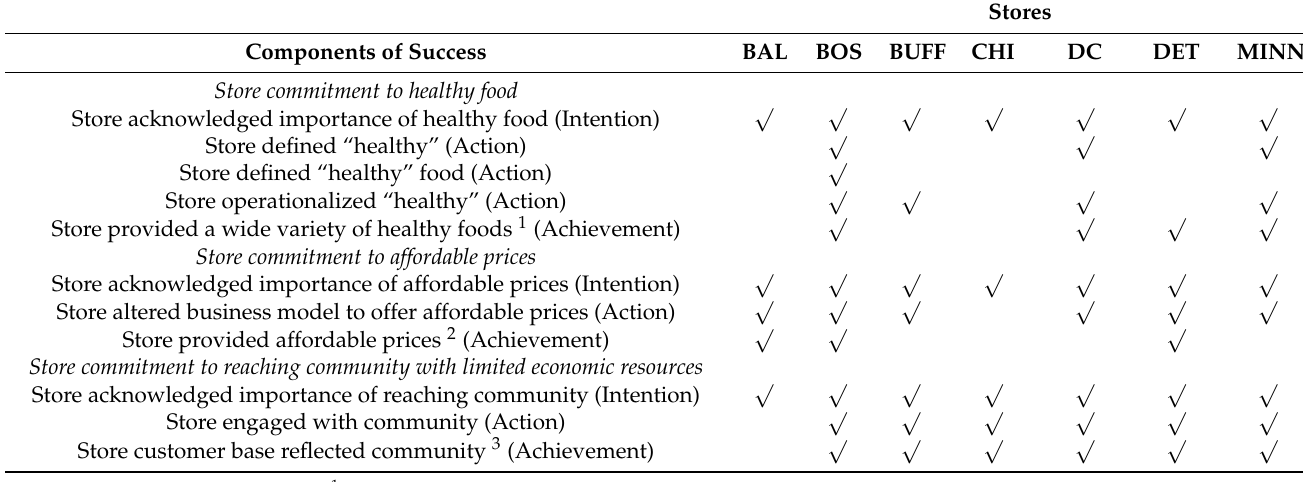
Table 2. Healthy community store success: intention, action, and achievement by store.